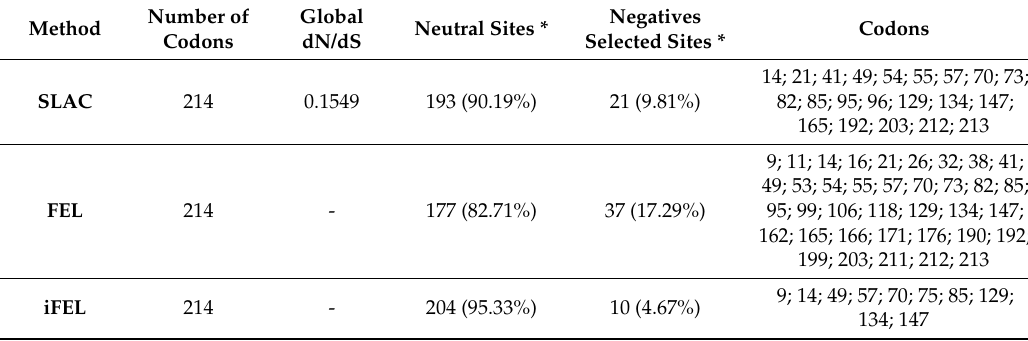
Table 3. Codon selection pressures on the sequences of